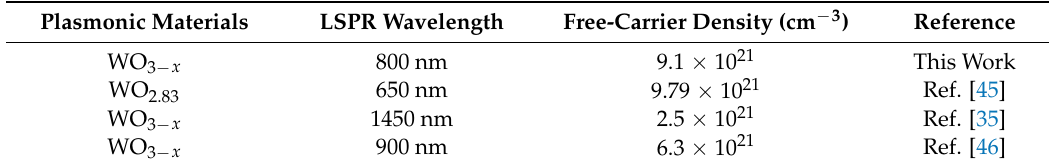
Table 1. The free electron concentration of a previously reported plasma-doped WO 3 − x